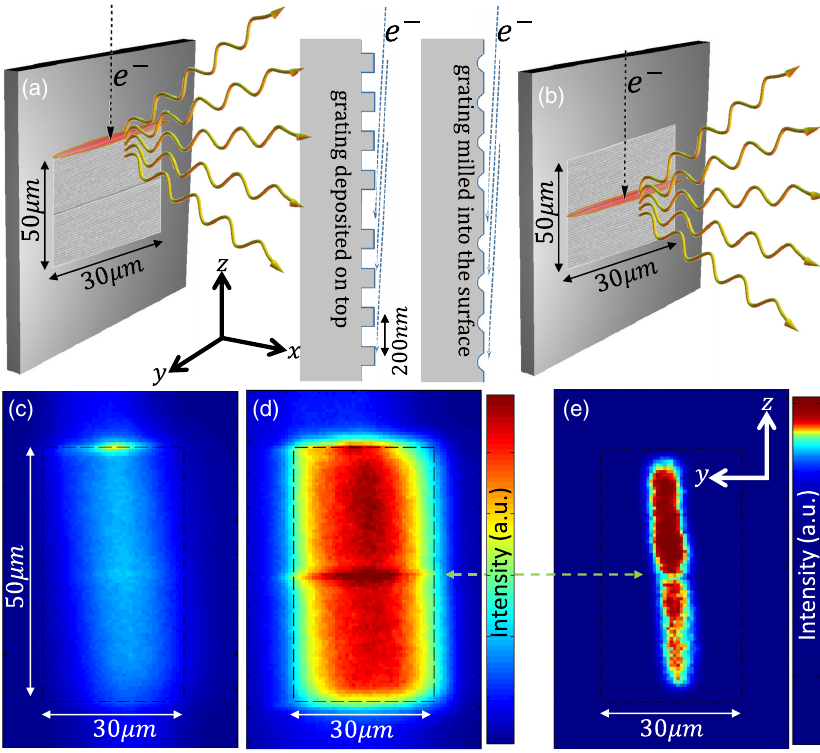
FIG. 3. Direct imaging of enhanced and inhibited emission from line defect . (a,b) Illustration of the electron beam (dashed black arrow) interacting with line defects fabricated in the samples. (c – e) False color optical images of the light emission from the samples showing a clear enhancement (c,d) or inhibition (e) of the emission from the edge of the periodic structure and from the line defect. The samples are fabricated by either electron beam lithography with silver deposition (c,d) or by focused ion beam milling of trenches into a silver film (e). These techniques result in different cross sections to the electrons interacting with the gratings, as illustrated by the grating profiles between (a) and (b), leading to enhanced and inhibited emission, respectively. The electrons ’ kinetic energy is 13 kV and 20 kV in (c) and (d,e),